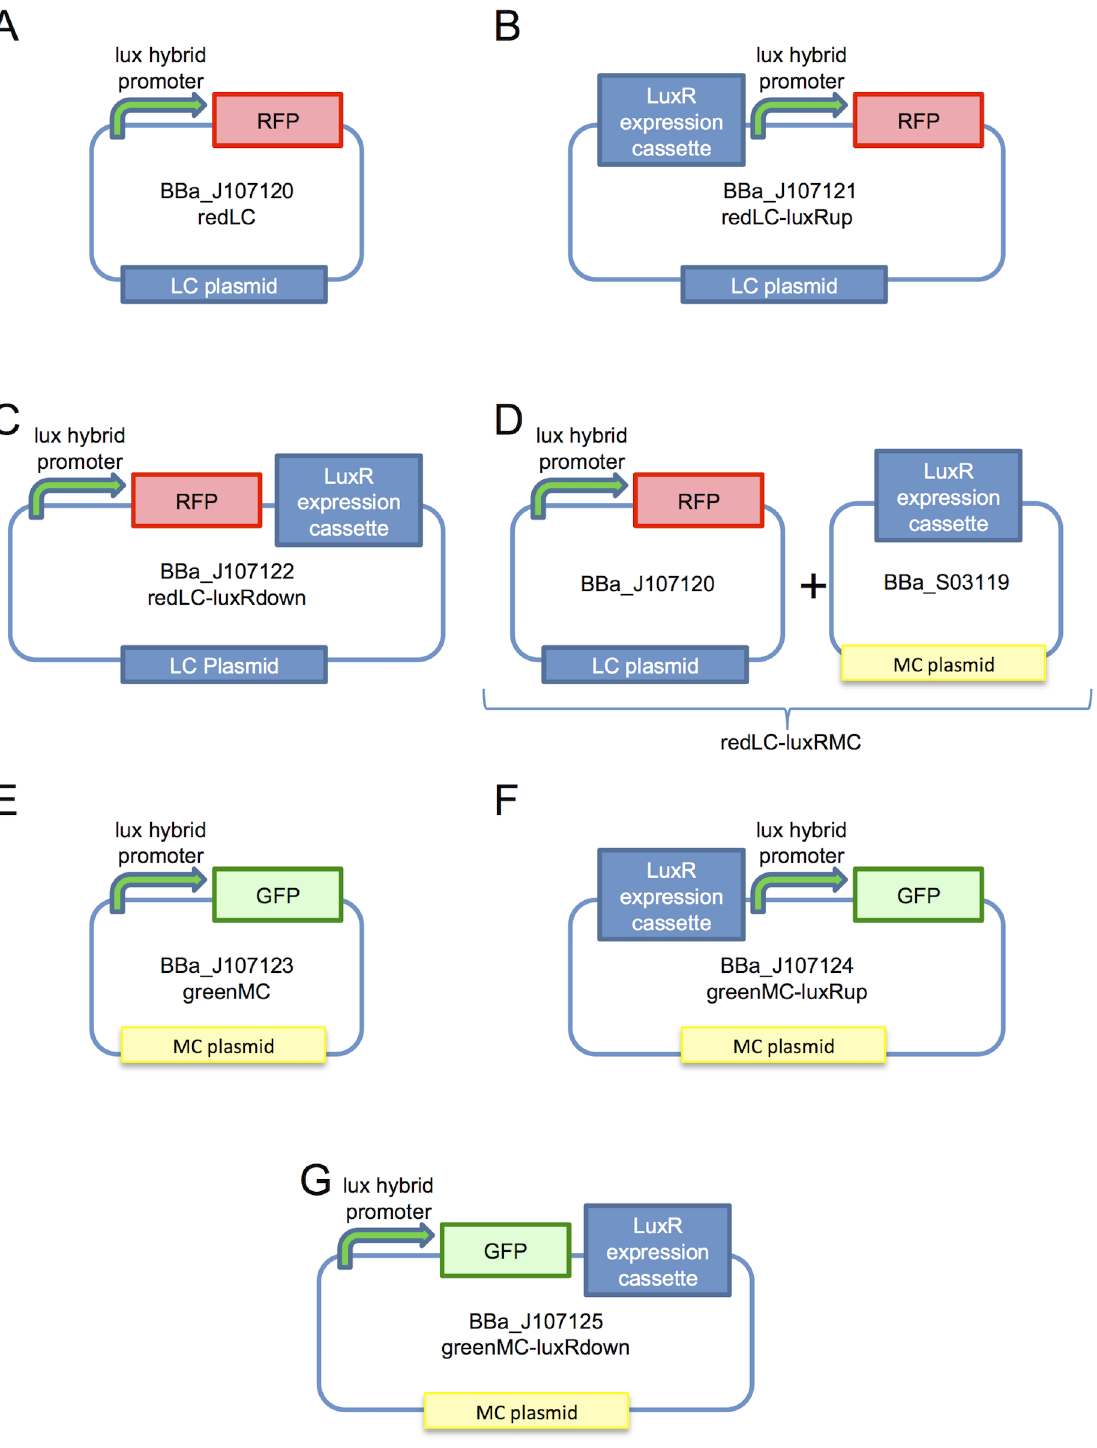
Fig 3. Configurations studied to test the 'position effect' of the LuxR-expression cassette. Here, the LuxR-repressible promoter BBa_J107100 (green curved arrow), driving the expression of RFP (red box) or GFP (green box), has been assembled in different configurations: in low-copy pSB4C5 (LC) plasmid with the RFP reporter gene A) without the LuxR-expression cassette, B) assembled downstream or C) upstream of the LuxR-expression cassette, and D) co-transformed with the LuxR-expression medium-copy plasmid pLuxR-MC; in medium copy pSB3K3 (MC) plasmid with the GFP reporter gene E) without the LuxR-expression cassette, F) assembled downstream or G) upstream of the LuxR-expression cassette. The BioBrick codes are indicated for each part and a name is provided for each configuration. The '+' symbol in panel D indicates that both plasmids are co-transformed in the cell.